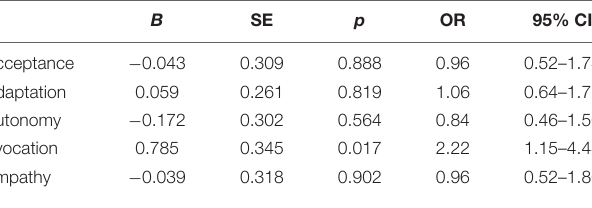
TABLE 7 | Motivational interviewing (safeguard).